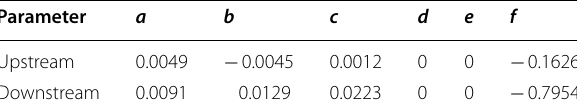
Table 4 Elliptic general equation parameters